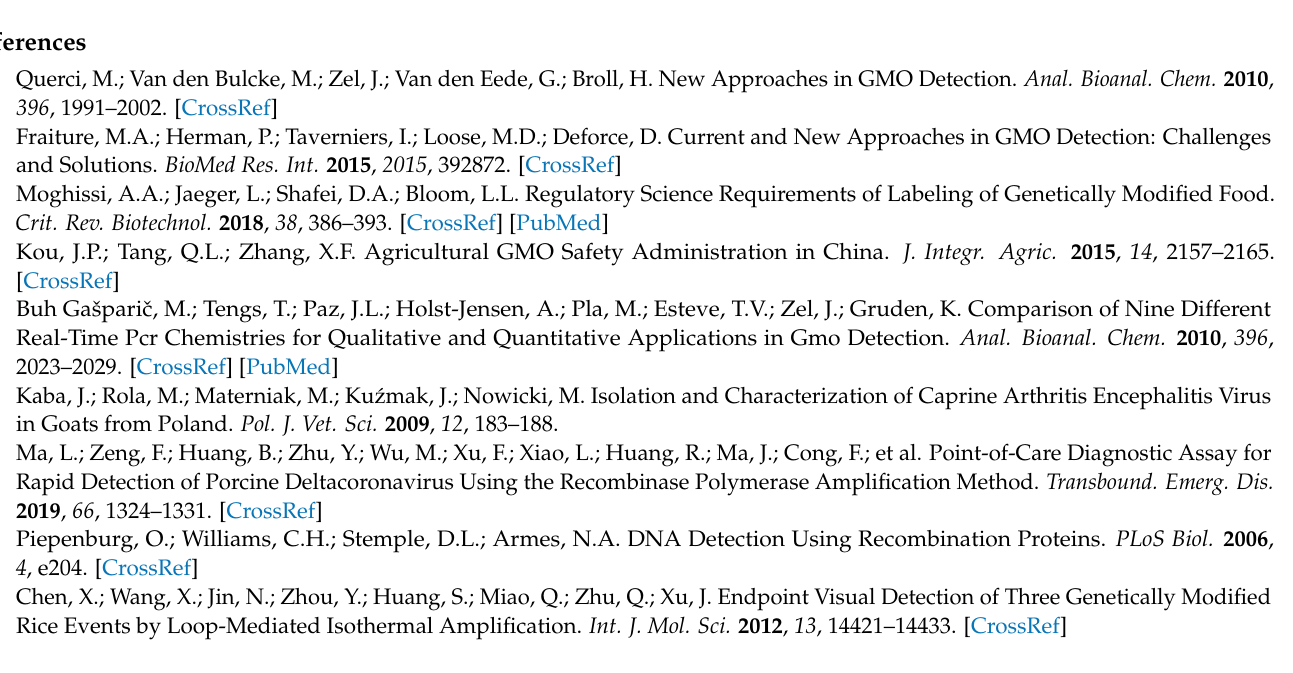
Table S1: The list of all used sequences in this study; Table S2: Ct values of qPCR for T-nos detection from 11 soybean DNA